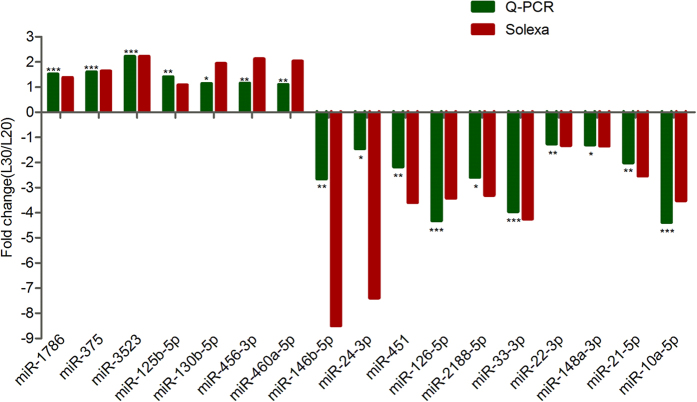
QRT-PCR verification of differentially expressed miRNAs.*P ≤ 0.05; **P ≤ 0.01; ***P ≤ 0.001. Fold-change > 0 indicates up-regulation; fold-change < 0 indicates down-regulation.